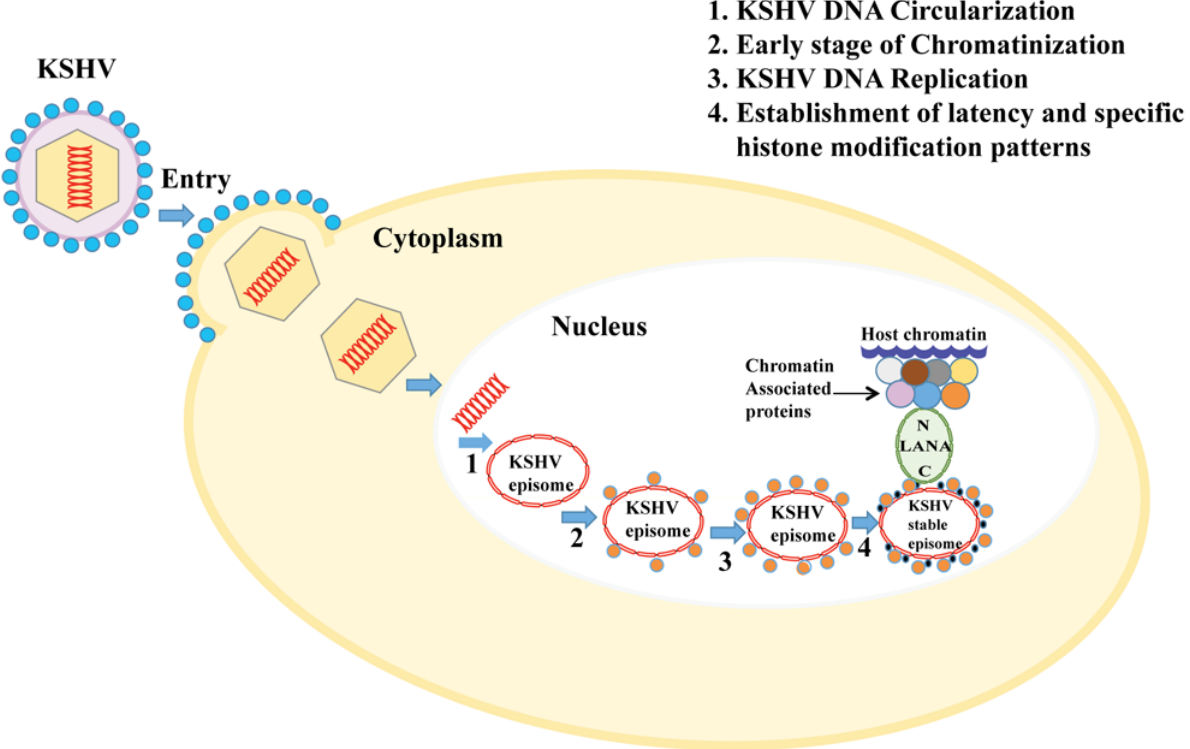
Figure 1. The chromatinization and maintenance of the KSHV genome following de novo infection: After the KSHV virion attaches to the host cell, the viral capsid enters the cytoplasm, followed by the ejection of viral DNA into the nucleus. Subsequently, the linear viral genome is circularized into an extrachromosomal episome to avoid detection by the host DNA damage response; (2) Circularized genome is further chromatinized using cellular histones and histone modifying factors resulting in a stable episome; (3) Viral genome, which is being maintained as multicopy chromatinized episome then replicates along with the cellular genome; (4) For the stable persistence and segregation of KSHV epigenome during latency, KSHV latent protein LANA binds to the TR region of the viral genome and tethers the viral genome to the host chromosome through its amino-terminus via interaction with histones and cellular chromatin associated